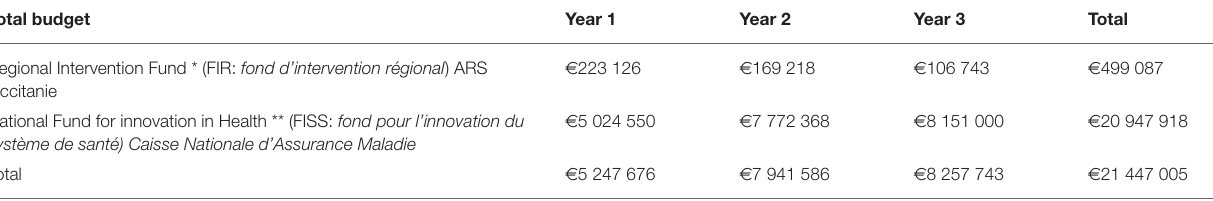
TABLE 4 | Funding allocated to the Experiment “ Parcours de Santé TSLA Occitanie ”. Total